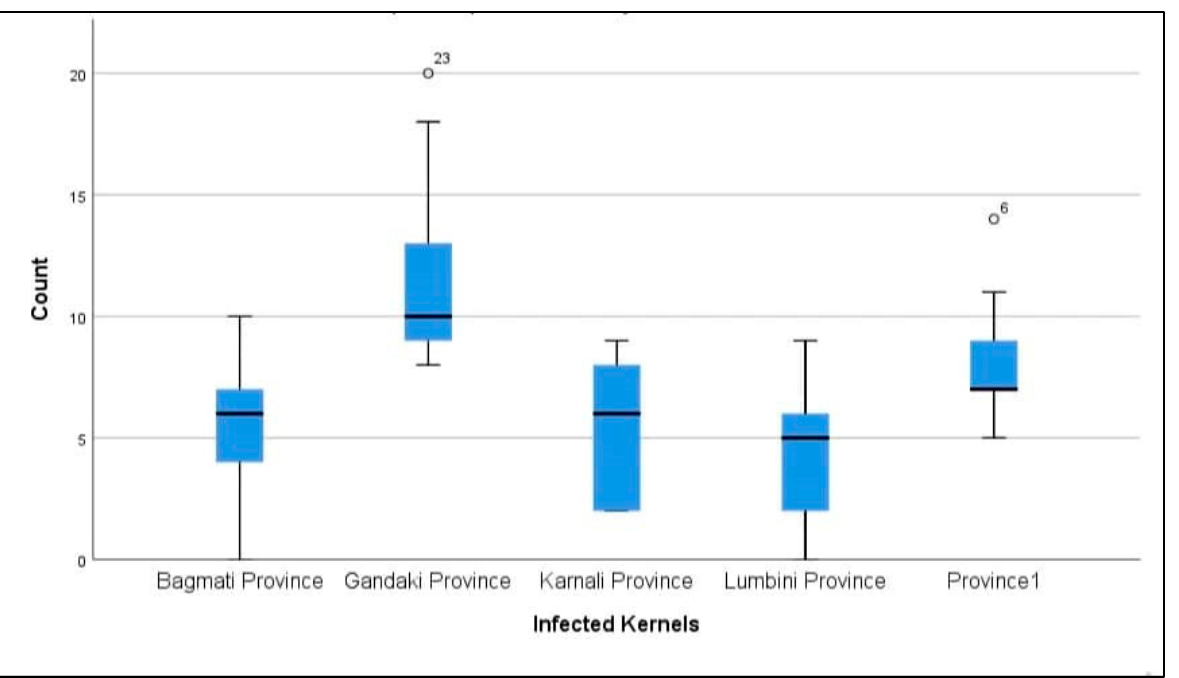
Figure A7. Contamination level of DON.